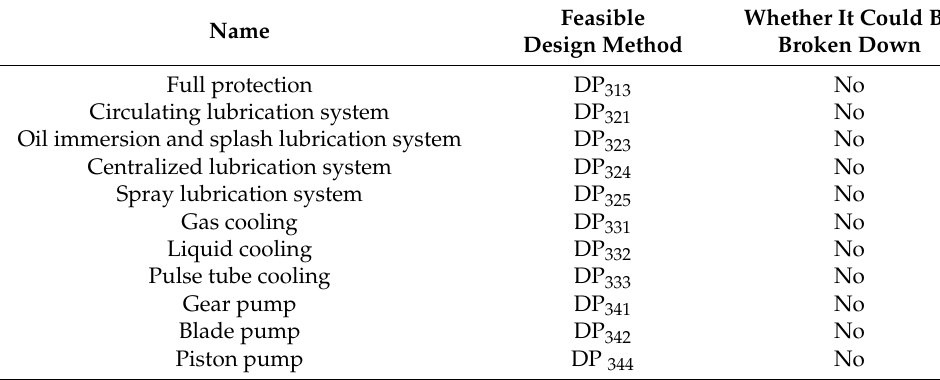
Table 10. List of terminal nodes for FR 31 , FR 32 , FR 33 , and FR 34.